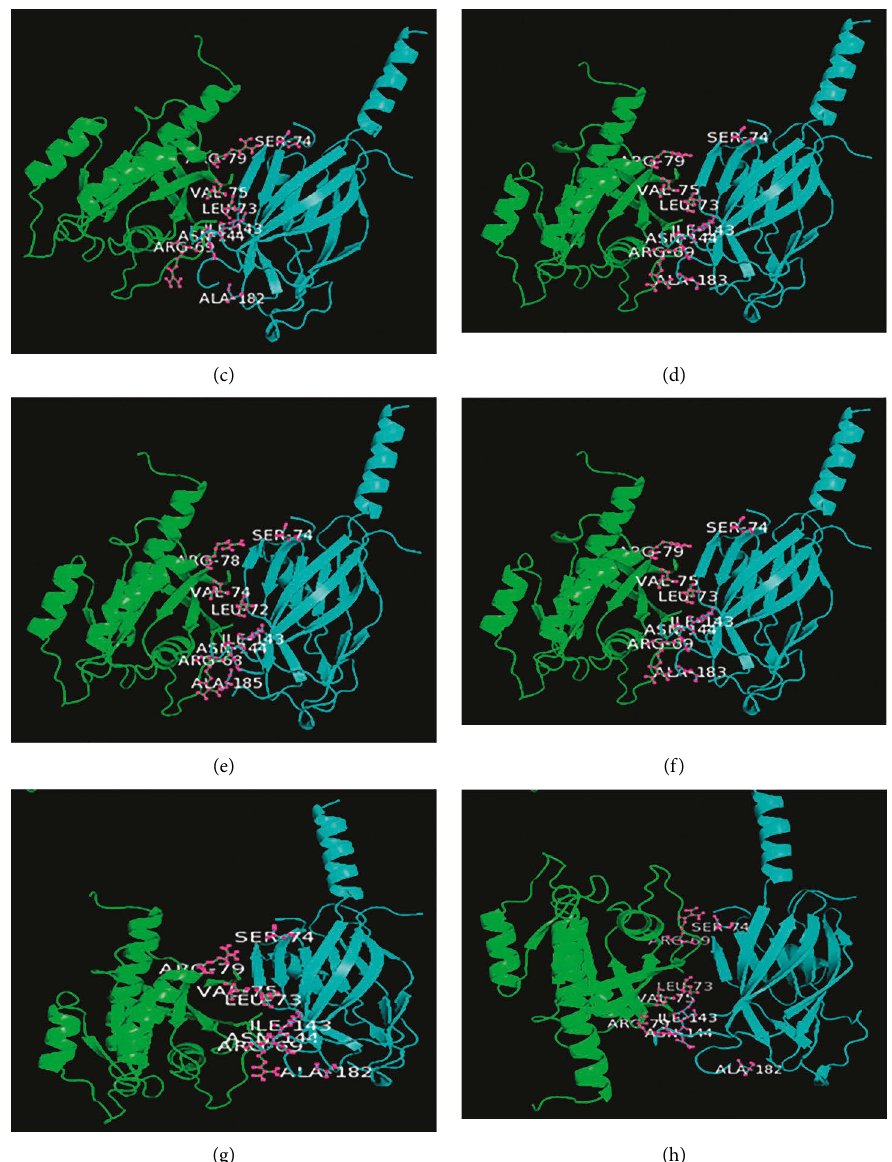
Figure 8: Protein-protein docking using HADDOCK 2.4 for Rab7 (left) from the isolates of (a) Actinia tenebrosa (b) Lingula anatina (c) Lottia gigantea (d) Capitella teleta (e) Priapulus caudatus (f) Daphnia magna and (g) Cyprinodon variegatus , and (h) a penaeid shrimp Penaeus vannamei with VP28 (right) of